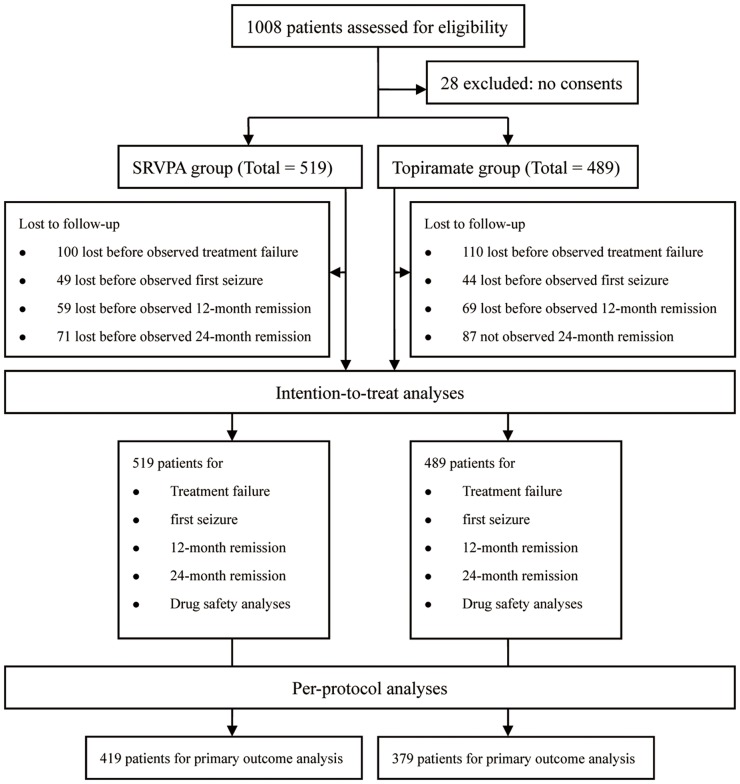
Study flow diagram.